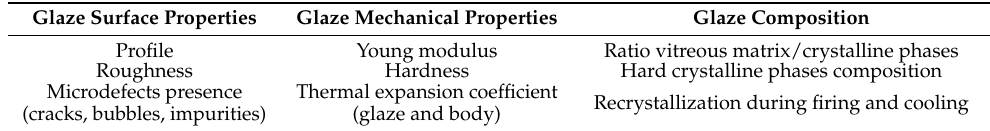
Table 1. Glazes parameters influencing metal marking behavior.